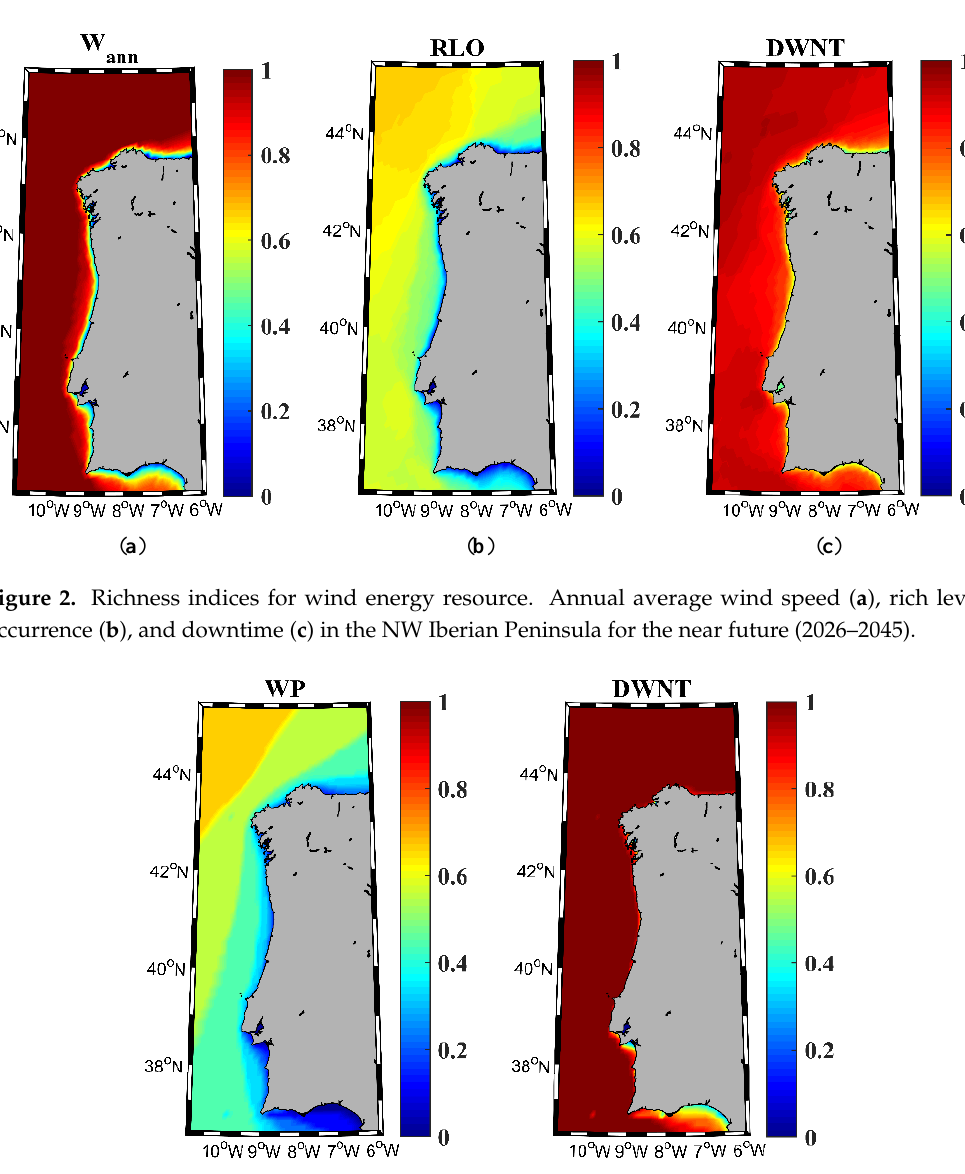
Figure 3. Richness indices for wave energy resource. Wave power ( a ) and downtime ( b ) in the NW Iberian Peninsula for the near future (2026–2045).